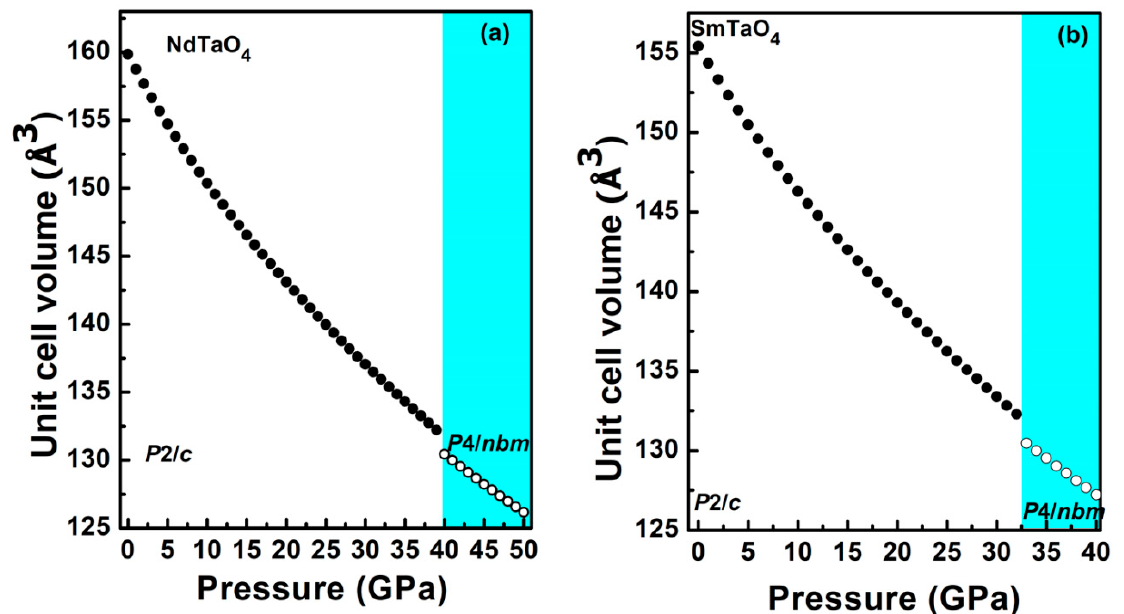
Figure 4. Pressure dependence of the unit cell lattice volume for the compounds ( a ) NdTaO 4 and ( b ) SmTaO 4 , of the low-pressure phase (solid circle) and the high-pressure phase (empty circle). The colored region describes the high-pressure tetragonal phase.